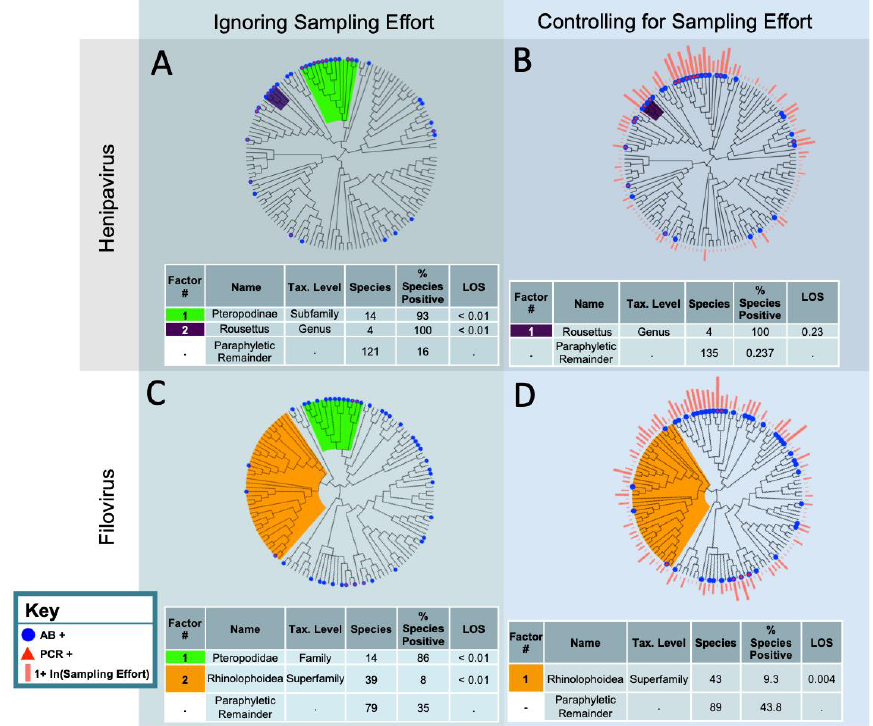
Figure 1. Phylofactorization of the bat species that have been PCR or antibody positive for filoviruses and henipaviruses. The phylogeny is from the Open Tree of Life. The analysis was performed using generalized phylofactor regression. The outcome variable is evidence of infection, determined using either PCR or antibody positivity. The factor name and taxonomic level was determined by identifying the most basal taxonomic grouping shared by all species in the clade. The % species positive is the proportion of species PCR or antibody positive within the factor. Level of significance (LOS) refers to the value of the objective function for a clade in relation to the distribution of objective function values from the null simulations. Factors are ordered from top to bottom by their LOS. ( A ) Analysis excludes bats that have not been sampled for henipaviruses and does not account for sampling effort. ( B ) Analysis excludes bats that have not been sampled for henipaviruses and does account for sampling effort. ( C ) Analysis excludes bats that have not been sampled for filoviruses and does not account for sampling effort. ( D ) Analysis excludes bats that have not been sampled for filoviruses and does account for sampling effort.